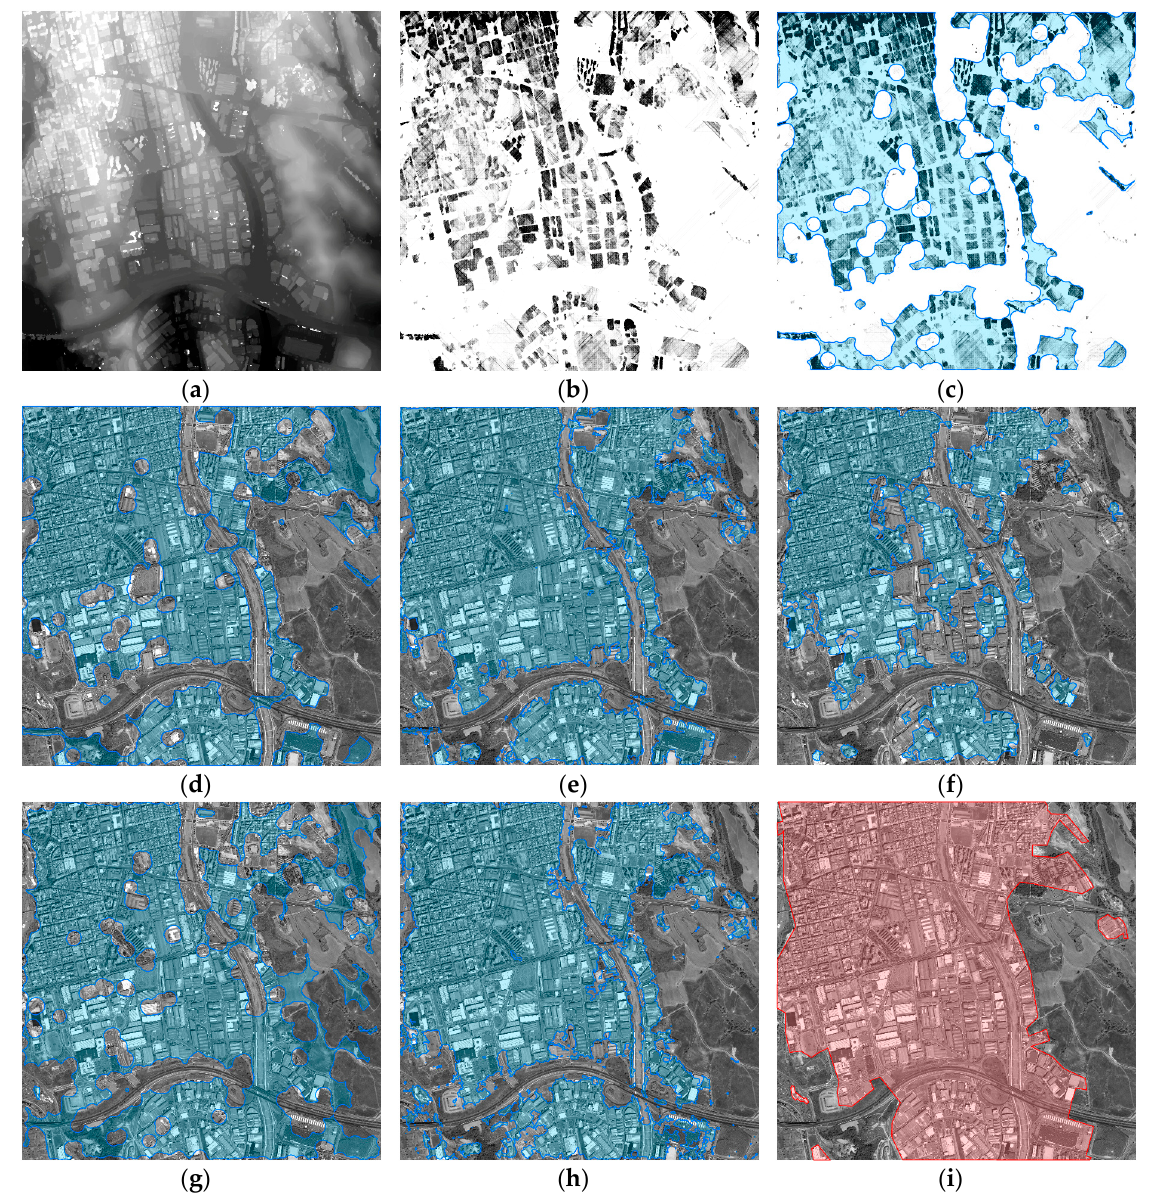
Figure 11. ( a – i ) Results for stereo pair 2. Descriptions of the content are the same as those in Figure